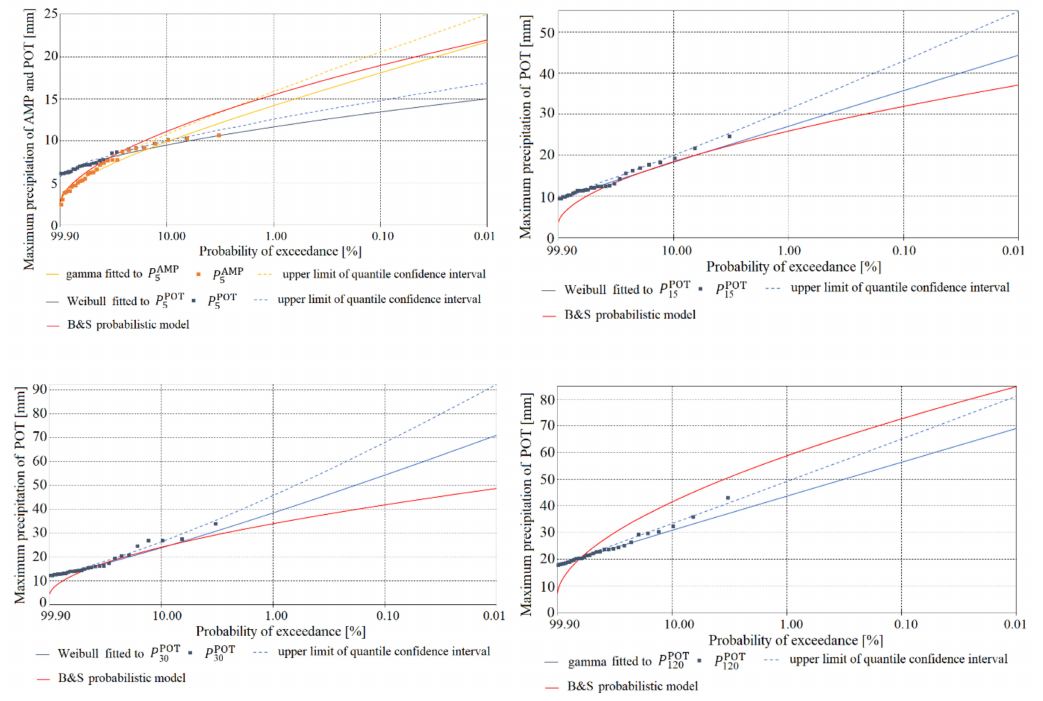
Figure 5. Plots of functions of probability of exceedance for the random variables P AMP τ and/or P POT τ , where τ = {5, 15, 30, 120} min, for the most credible probability distributions, with indicated upper limits of quantile confidence intervals according to the PMAXTP method, compared with the model of Bogdanowicz and Stach ý , for the Chojnice meteorological station.